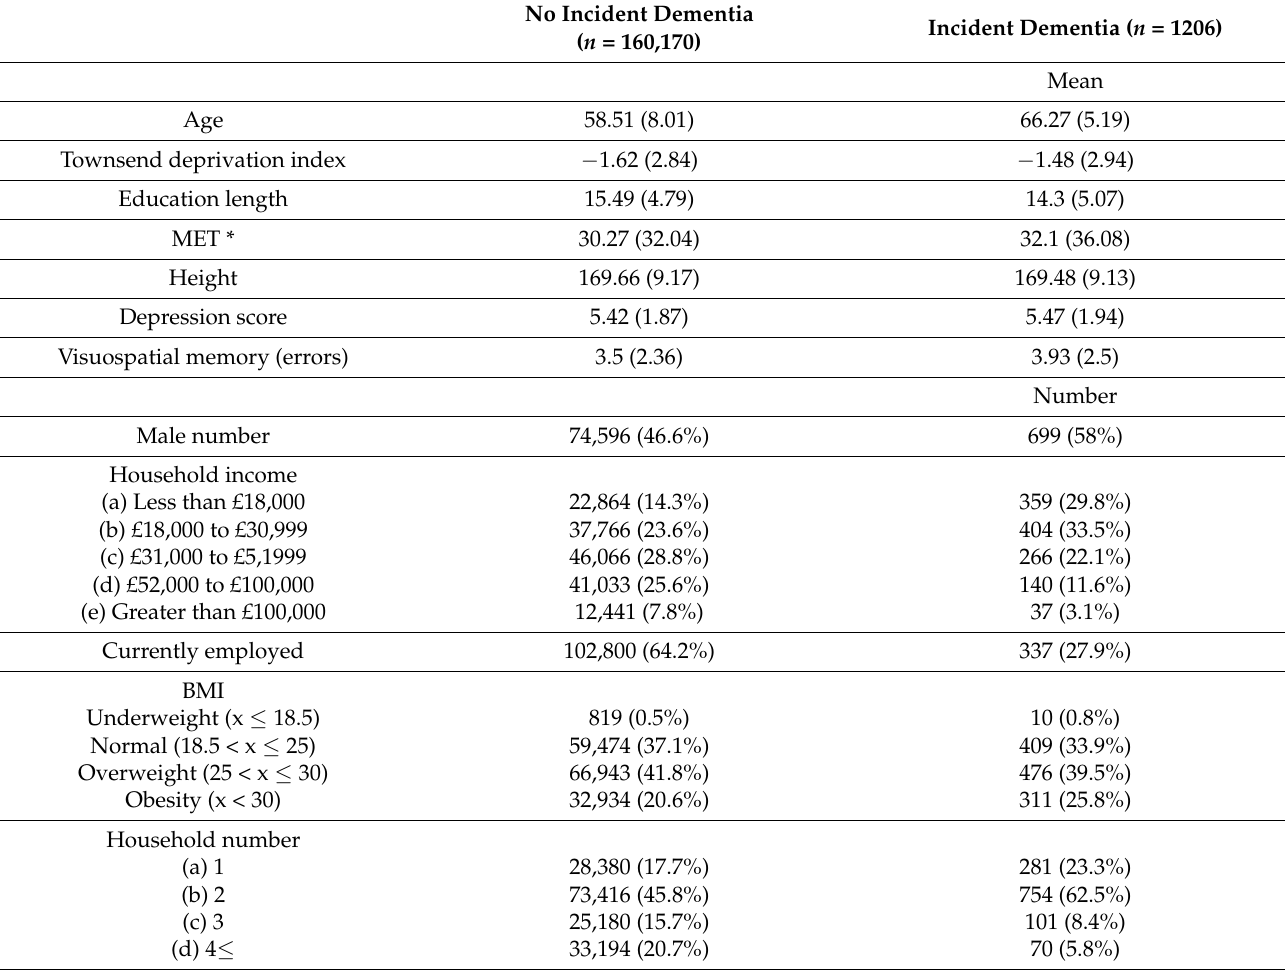
Table 1. Baseline characteristics of participants with and without incident